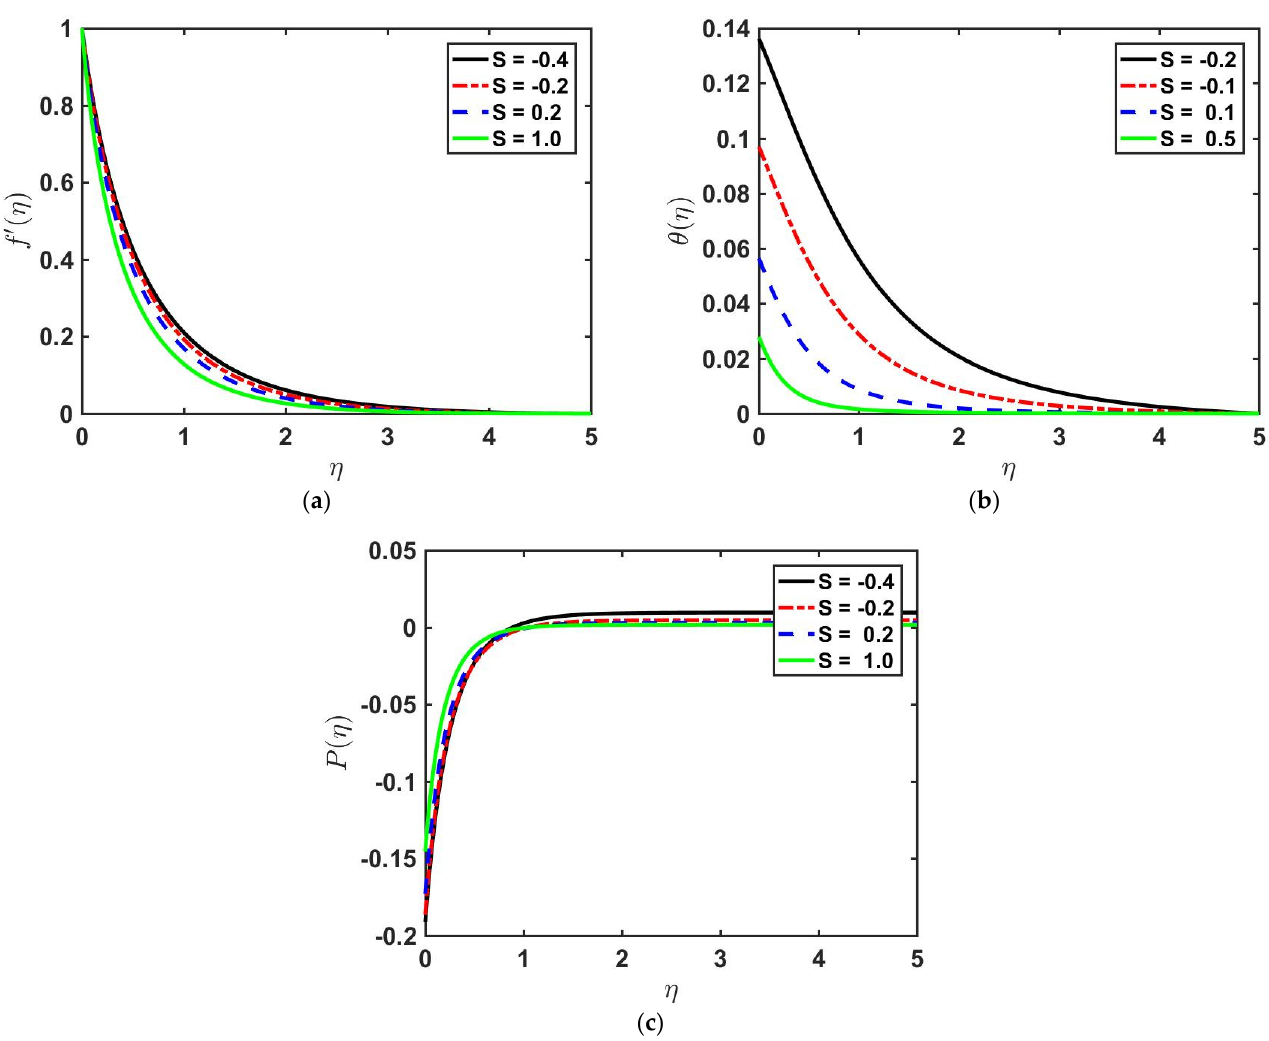
Figure 12. Effect of S on ( a ) f (cid:48) ( η ) , ( b ) P ( η ) , and ( c ) θ ( η )